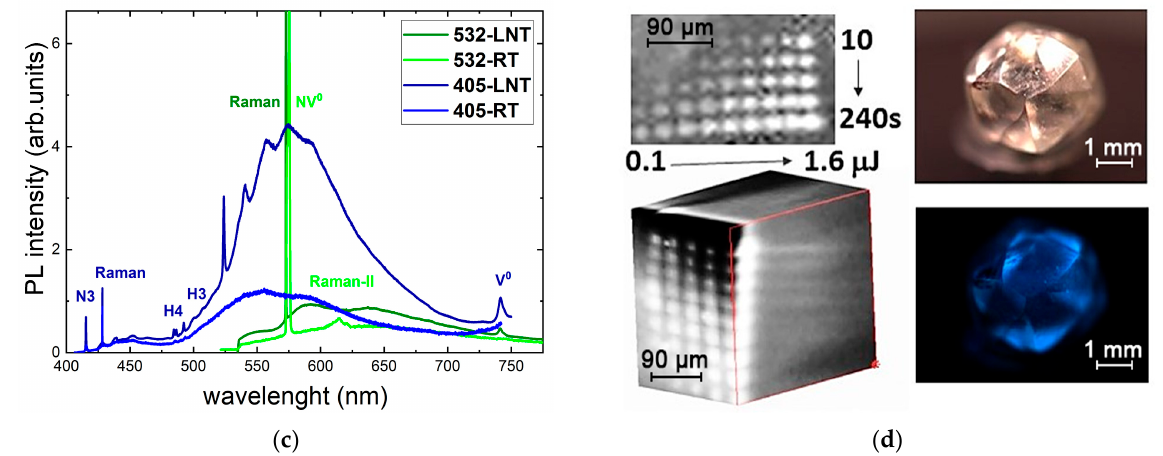
Figure 1. Spectral characterization of the initial diamond sample: ( a ) FT-IR spectrum (spectral assignment after [5]); ( b ) UV–NIR transmission spectrum; ( c ) RT and LNT PL spectra at 405 nm and 532 nm laser excitation; and ( d ) 3D confocal PL-based image of the bulk array of laser-inscribed micromarks (top and side views) as well as PL “Diamond view” images of the diamond.